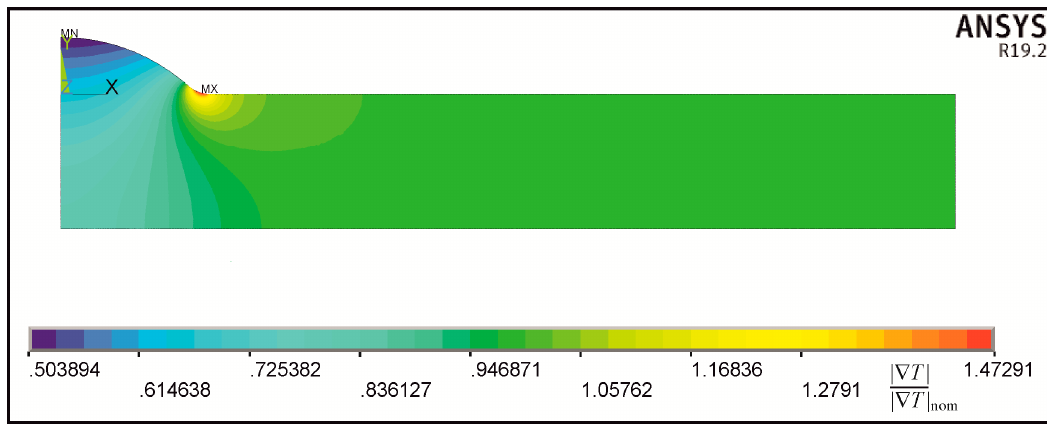
Figure 8. Magnitudes of the temperature gradient normalized with respect to | ∇ T | nom = 1 and corresponding to the temperature field shown in Figure 7.